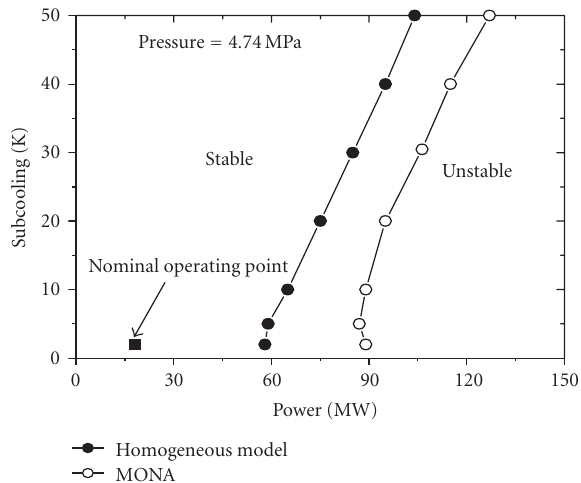
Figure 16: Comparison of stability maps between the homoge- neous model and the two-fluid model (RAMONA5).